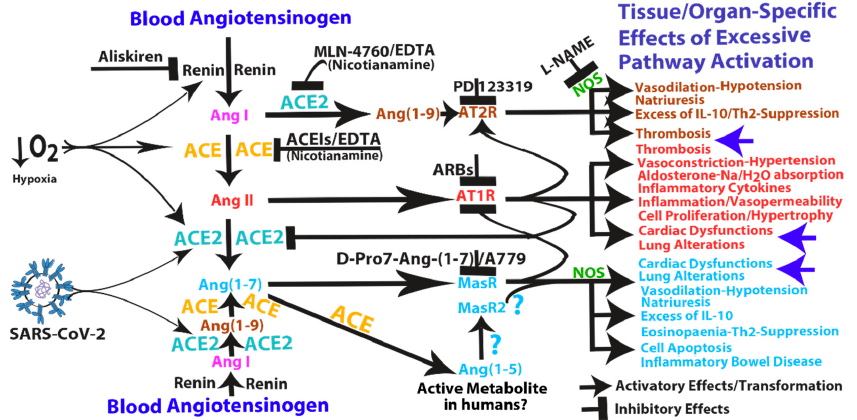
Figure 1. Interplay of regulation between the two arms of the renin-angiotensin system and pathophysiological consequences of excessive systemic activation of di ff erent RAS pathways. Reciprocal (ACE / ACE2) pathway inhibition, RAS inhibitor sites of action and influence of hypoxia / SARS-CoV-2 on the RAS are indicated. (for reference, see the